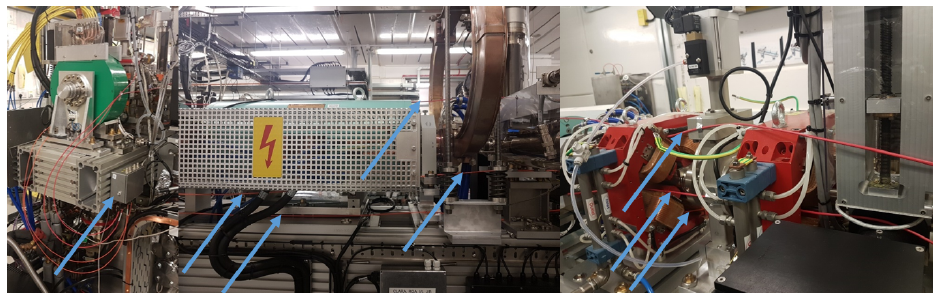
Figure 6. Example images of the optical fibre beam loss monitor installed on CLARA (STFC, UK). Fibres are indicated by blue arrows for